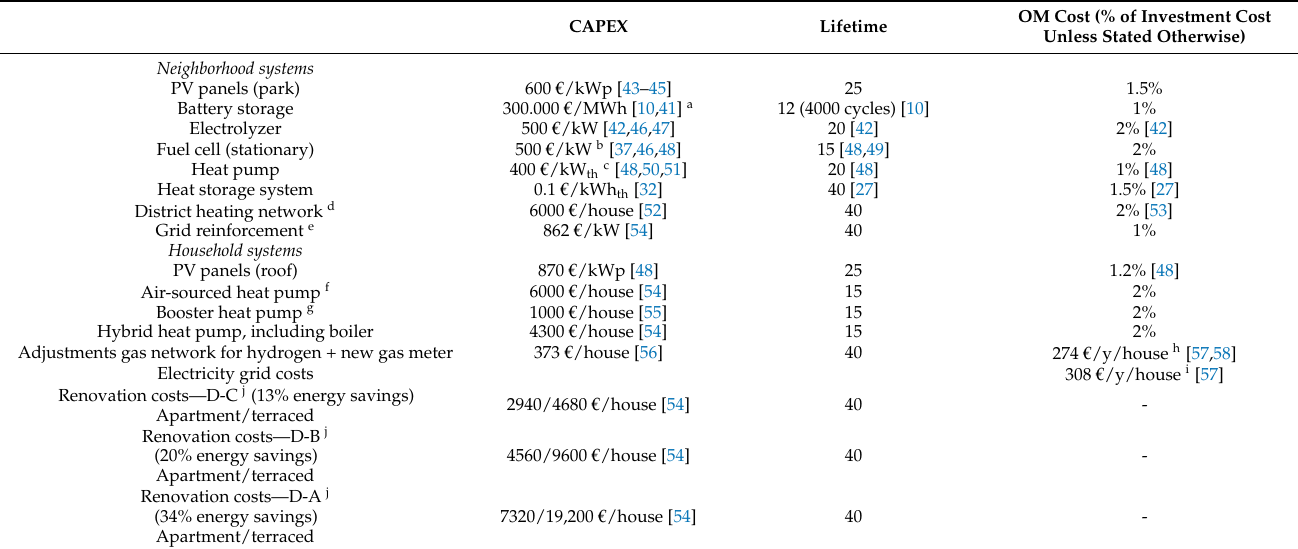
Table 2. Economic component parameters used in the model. CAPEX Lifetime OM Cost (% of Investment Cost Unless Stated